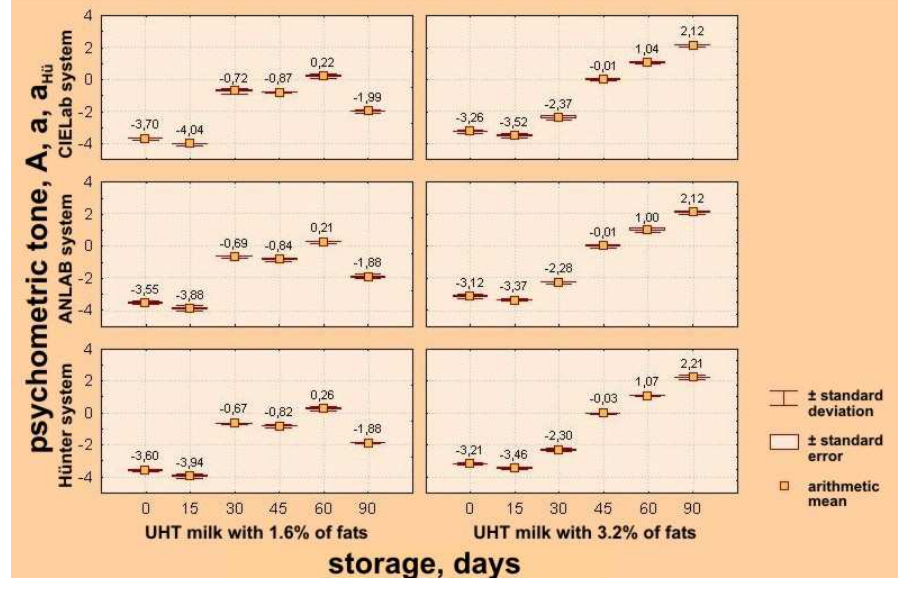
Figure 6 . Effects of storage time on changes of psychometric tone of UHT milk samples with 1.6% and 3.2% milk fat in CIELab, ANLAB and Hünter’s